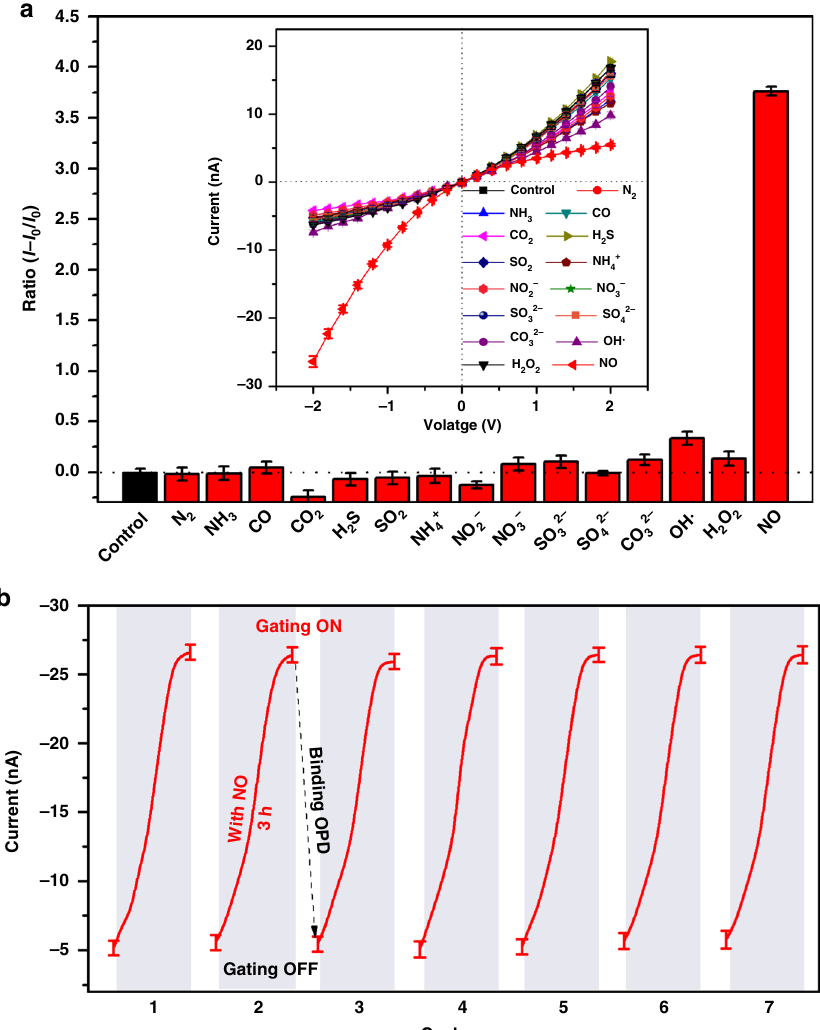
Fig. 4 Characterization of the gating performance. a Gating ratios measured at − 2 V in 0.1 M KCl, with addition of 1 mM various substrates; b the dynamic changes and recyclability of the NO-responsive